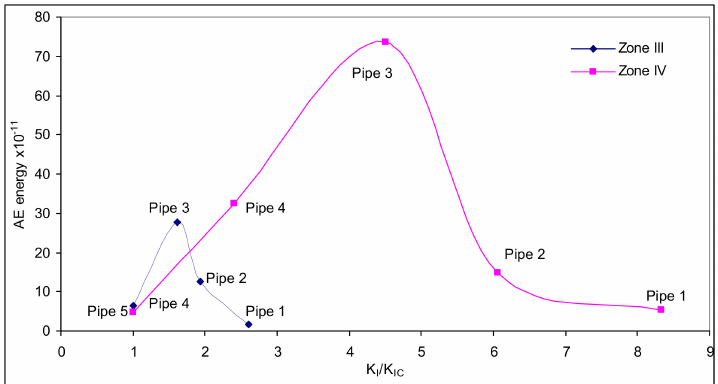
Figure 13. AE energy for Zones III and IV with stress intensity